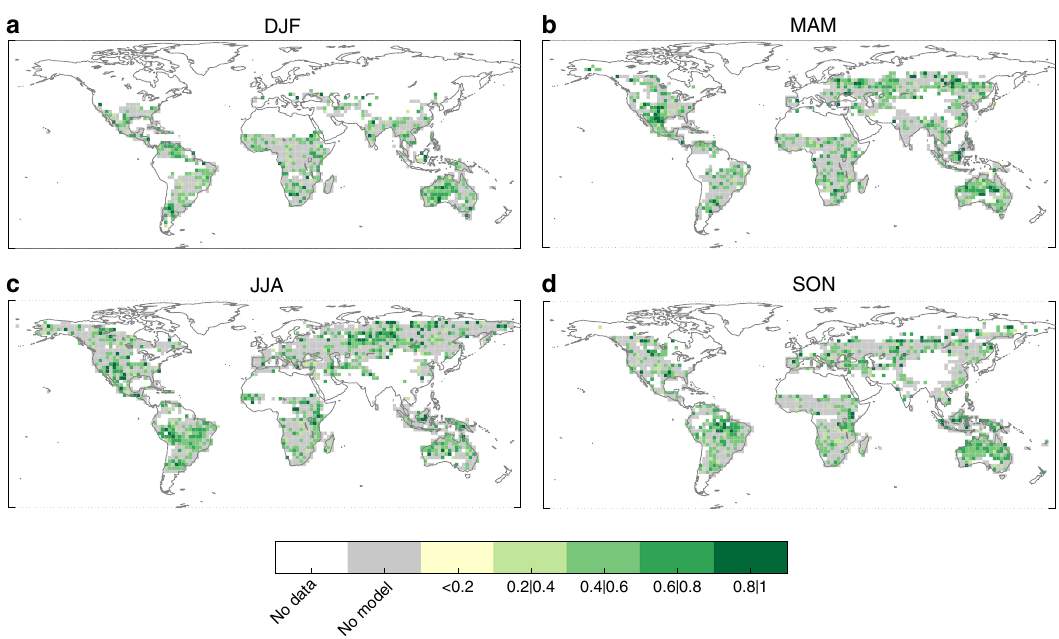
Fig. 5 Skill of burned area predictions obtained from the seasonal forecast ensemble BESTENS. Correlations of out-of-sample burned area (BA) predictions using the SPI – BA model fed with seasonal forecasts of SPI from the BESTENS for a December – January – February (DJF), b March – April – May (MAM), c June – July – August (JJA) and d September – October – November (SON). Only correlations that are signi fi cant ( p -value < 0.05) are shown in green colours. Grey colour shadows the grid points with non-signi fi cant correlation values. White indicates areas where fi res do not occur (e.g. sea) or have not been